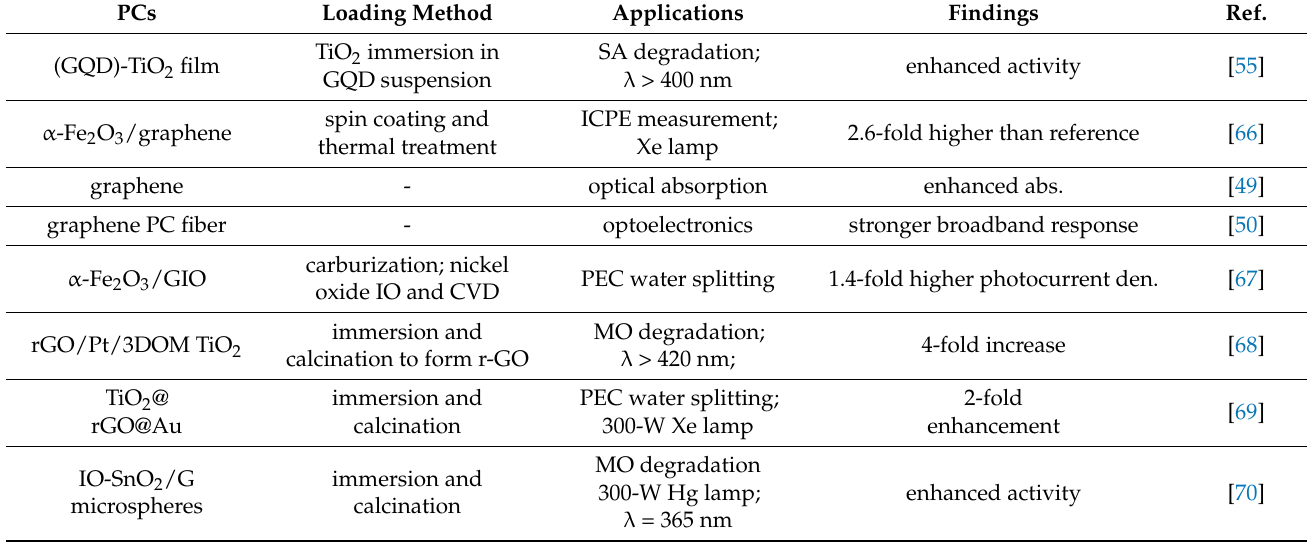
Table 1. Graphene-modified PCs: preparation, properties and